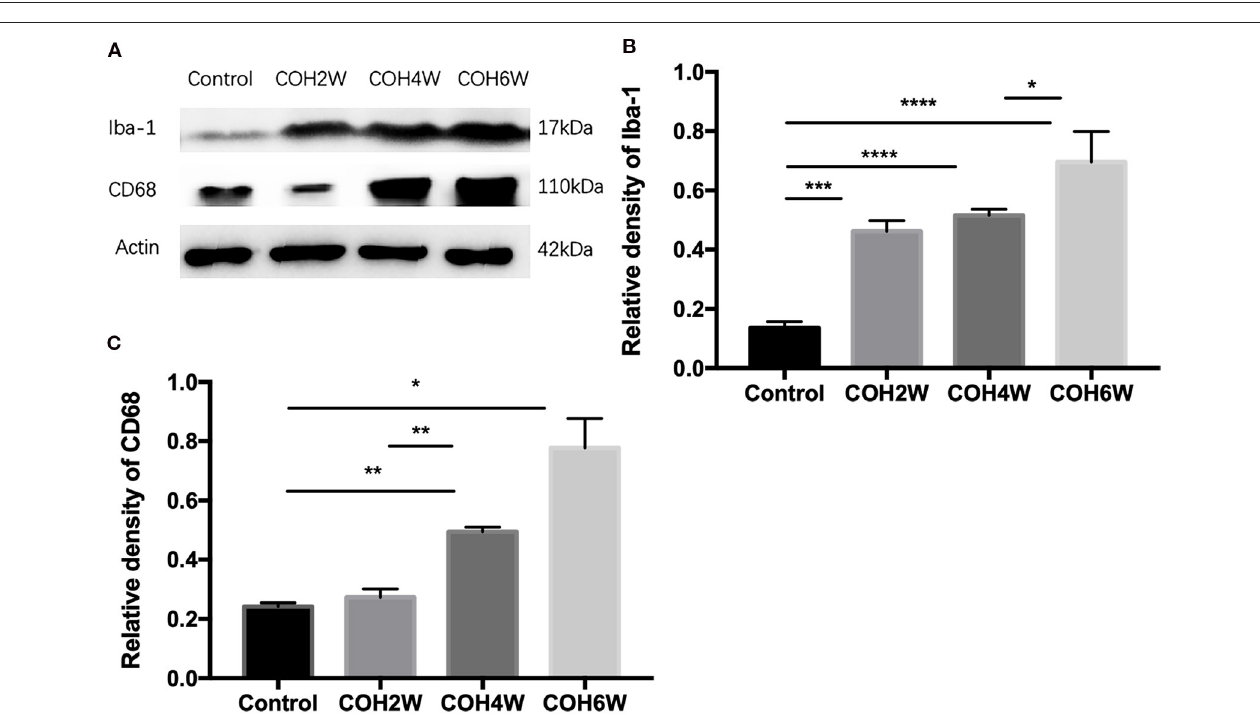
FIGURE 6 | Western blotting of retinal expressions of Iba-1 and CD68. (A) Bands of western blotting. (B,C) Quantitative analysis of western blotting gray values. The expression of Iba-1 and CD68 increased after the second week of COH. Data were analyzed using one-way ANOVA followed by Tukey’s post hoc test (* p < 0.05, ** p < 0.01, *** p < 0.001, and **** p < 0.0001). N = 20 mice (control group: 5 mice; hydrogel injection group: 15 mice). Bars represent mean ± SD.